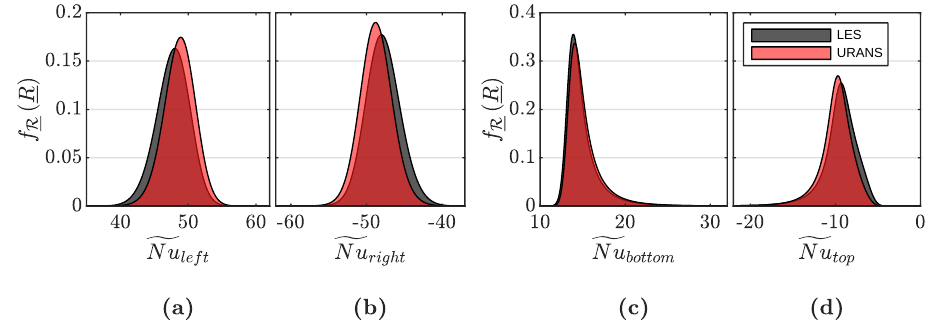
Figure 13. Probability density functions for the integral mean Nusselt number: ( a ) on the left wall, (cid:102) Nu left ; ( b ) on the right wall, (cid:102) Nu right ; ( c ) on the bottom wall, (cid:102) Nu bottom ; and ( d ) on the top wall, (cid:102) Nu top . The distributions for (cid:99) Nu left and (cid:99) Nu right in Figure 14a,b, approximately resemble the